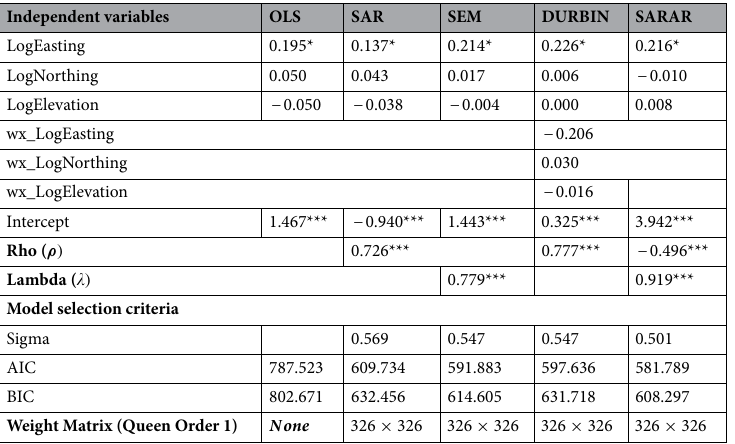
Table 5. Predictors of annual precipitation and selection criteria estimates. * p < 0.10, ** p < 0.05, *** p <